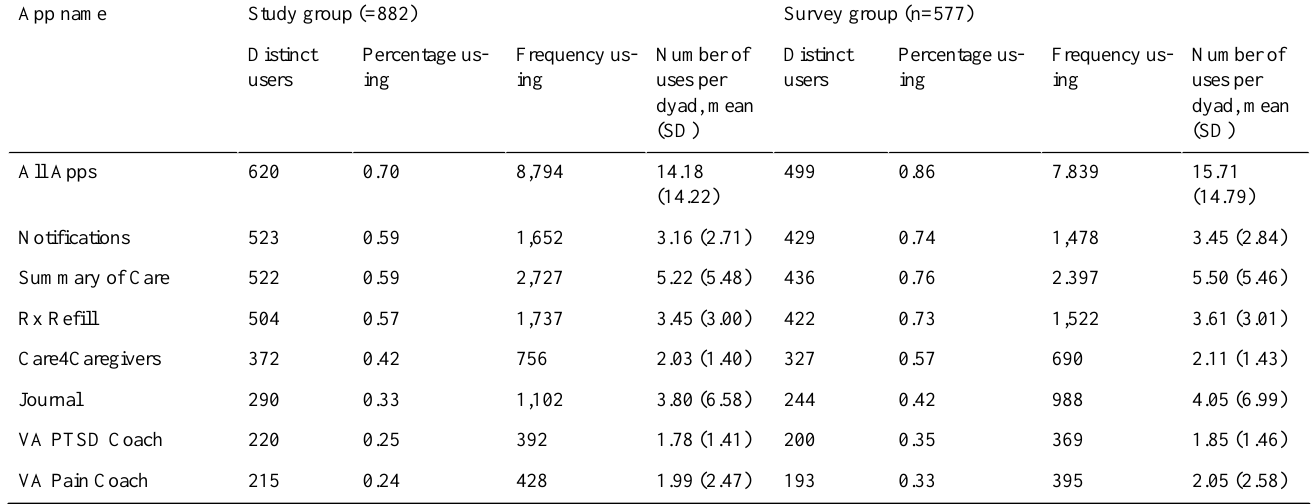
Table 2. mHealth app use in study and survey groups